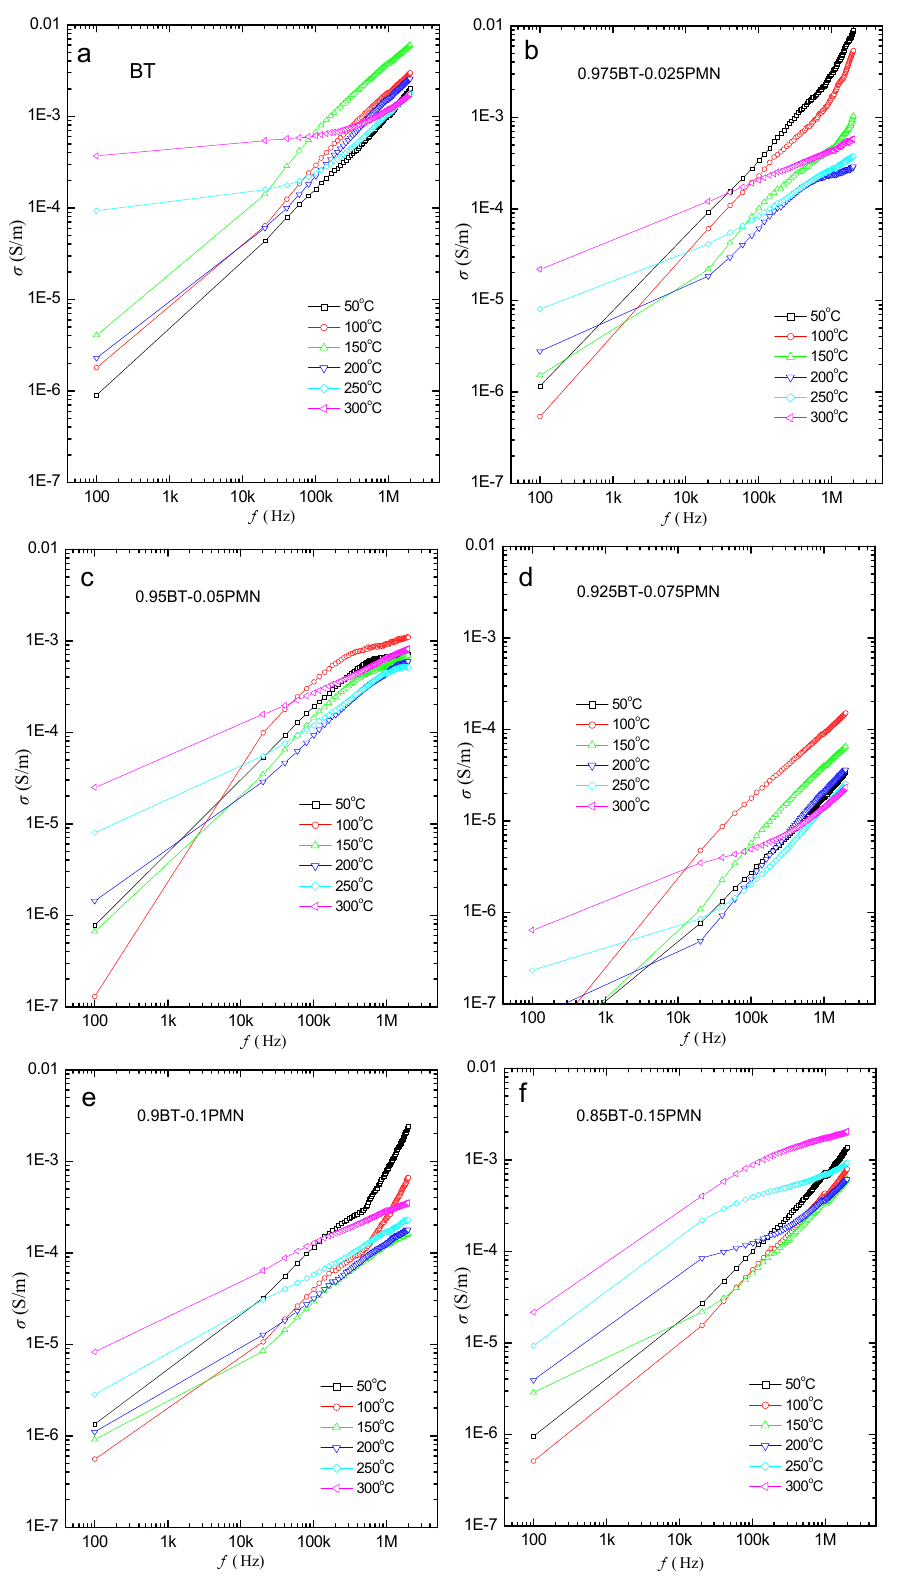
Fig. 7 Ac conductivity as a function of frequency at different temperatures for (1  x )BT– x PMN ceramics: (a) x = 0, (b) x = 0.025, (c) x = 0.05, (d) x = 0.075, (e) x = 0.1, and (f) x =